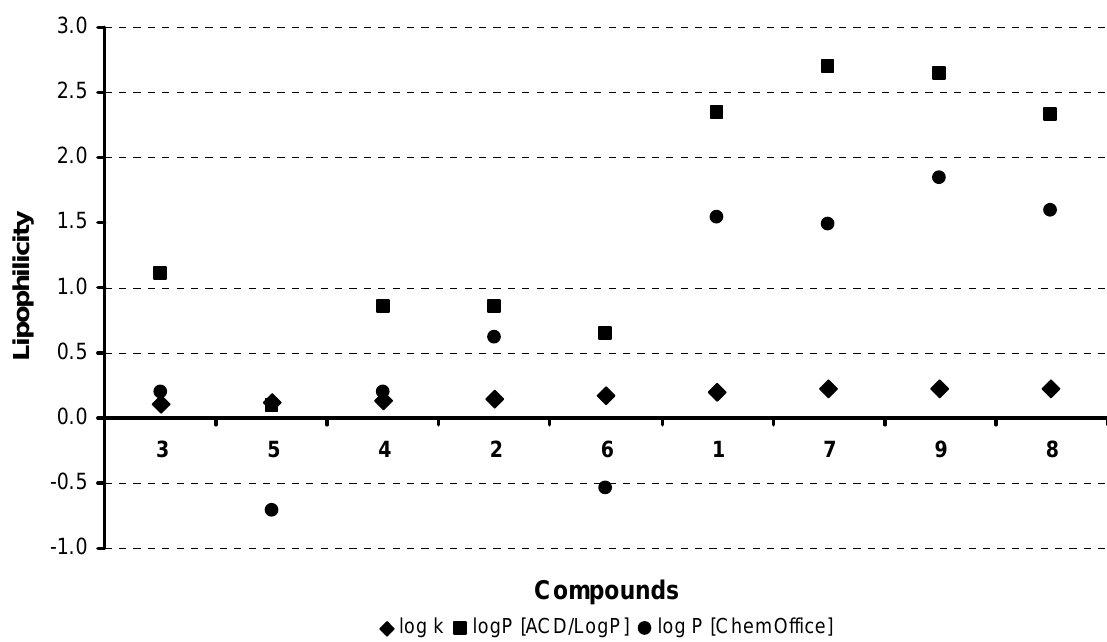
Figure 2. Comparison of the log P data calculated using the two programs with the experimentally found log k values. The compounds are arranged in the ascending manner according to the experimental log k